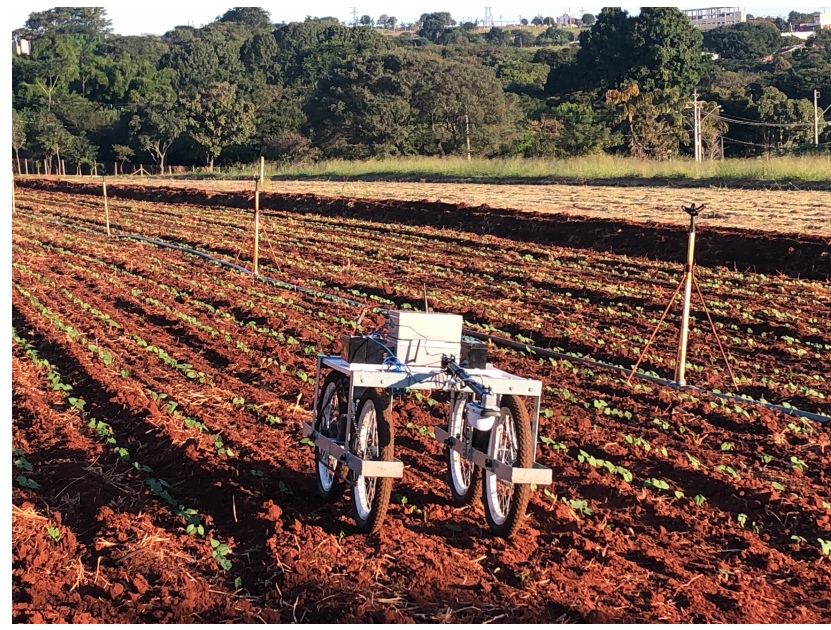
Figure 10. DARob in the acquisition process in the FEAGRI